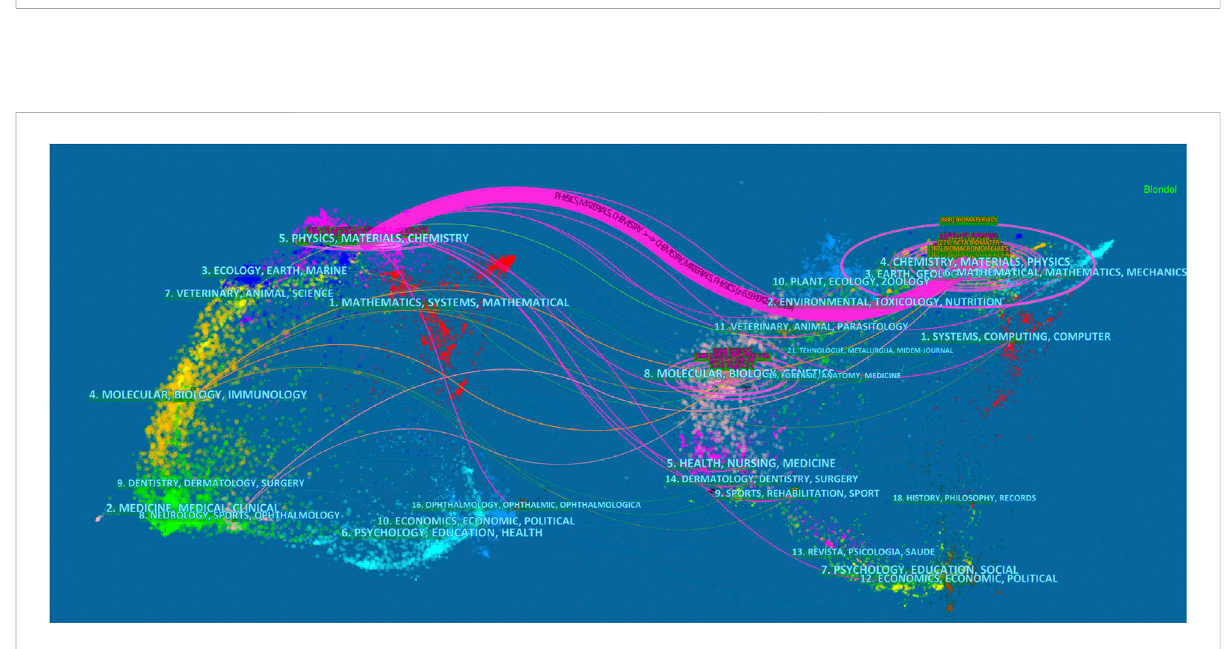
hotspot was still how to make better use of TPP as “ additional manufacturing ” and “ 3D printing ” technology to fabricate “ microstructures. ”